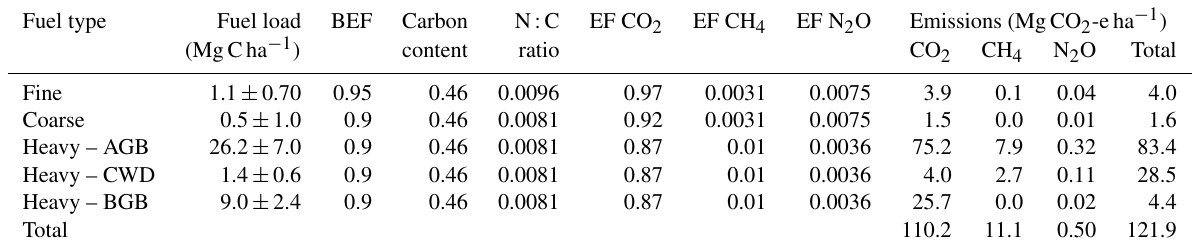
Table 4. Measured fuel loads, assumed burning efficiencies (BEFs), carbon contents, N:C ratio and emissions factors (EFs) used to estimate GHG emissions from the burning of the post-deforestation fine, coarse and heavy fuel debris. Emission factors, carbon content and C:N ratio were assumed for the vegetation fuel type woodland savanna with mixed grass (code hWMi) as given in the Emissions Abatement through the Savanna Fire Management methodology (Commonwealth of Australia, 2015b), available at www.legislation.gov.au/Details/F2015L00344 and Meyers et al.